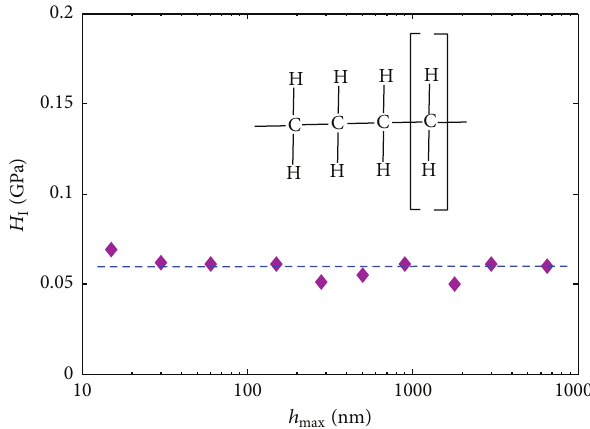
Figure 33: Indentation hardness of UHMWPE [15] and its molecu- lar structure [68].